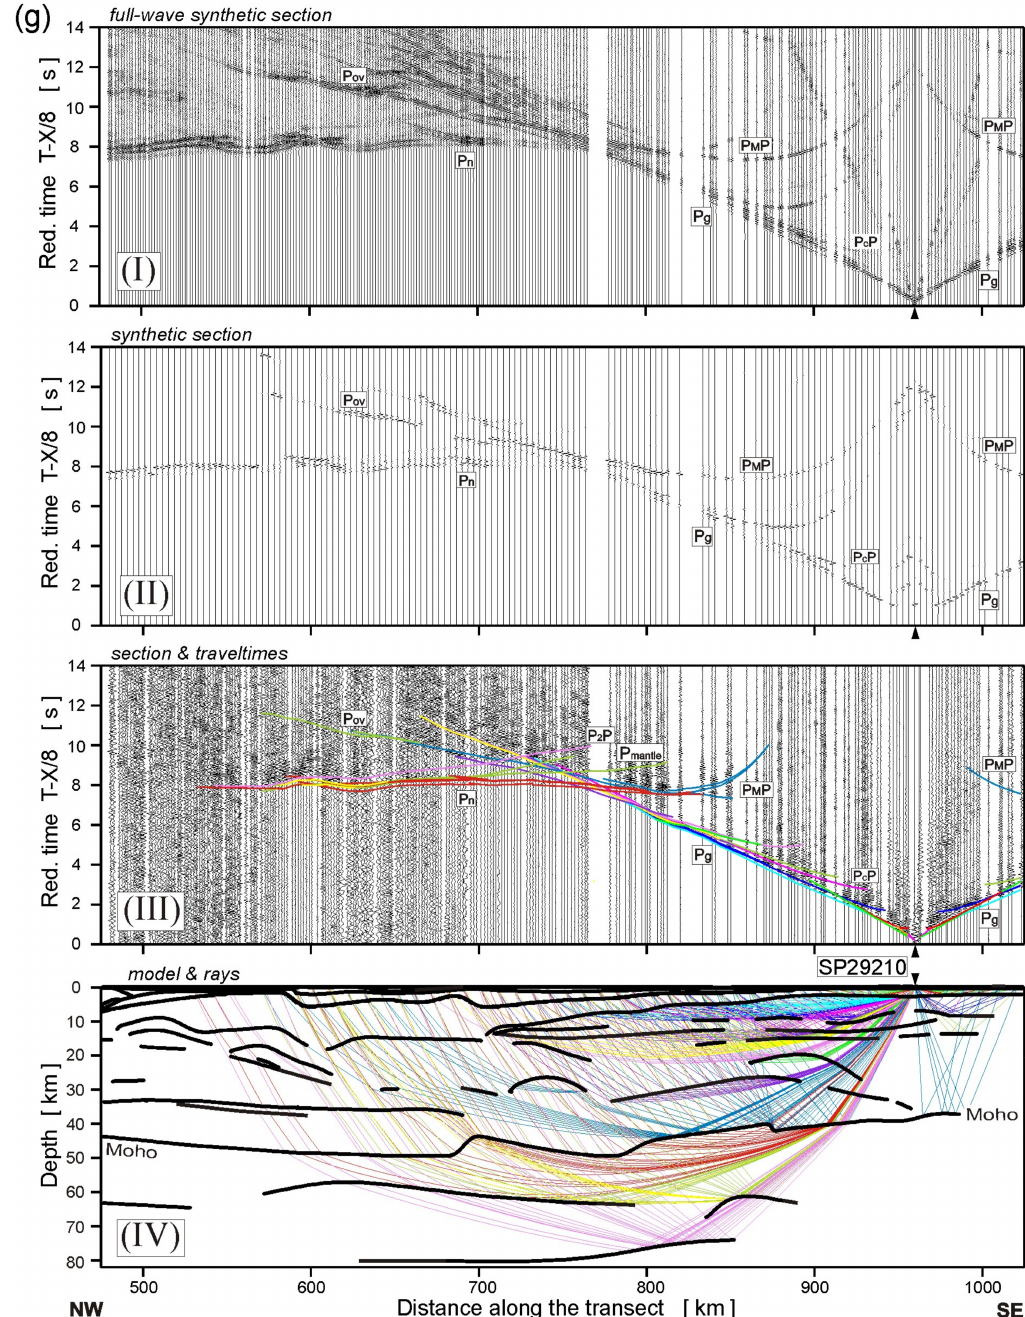
Figure 8. Examples of seismic modelling along the TTZ-South profile, for the model presented in Figure 7: ( a ) SP29201, ( b ) SP29202, ( c ) SP29204, ( d ) SP29205, ( e ) SP29207, ( f ) SP29208 and ( g ) SP29210. Diagrams: ( I ) Full-wave synthetic seismograms derived from the SEIS83 velocity model using TESSERAL package [110]; ( II ) Synthetic seismograms derived by using the SEIS83 package; ( III ) Seismic record section (trace-normalized, vertical-component, 2–15 Hz band-pass filtered, re- duction velocity of 8.0 km/s) of P-waves with theoretical travel-times calculated using SEIS83 [106]; ( IV ) Selected rays from SEIS83 defining the prominent model interfaces. Abbreviations of seismic phases as in Figure 5 and P 1 P, P 2 P—lower lithospheric P-wave